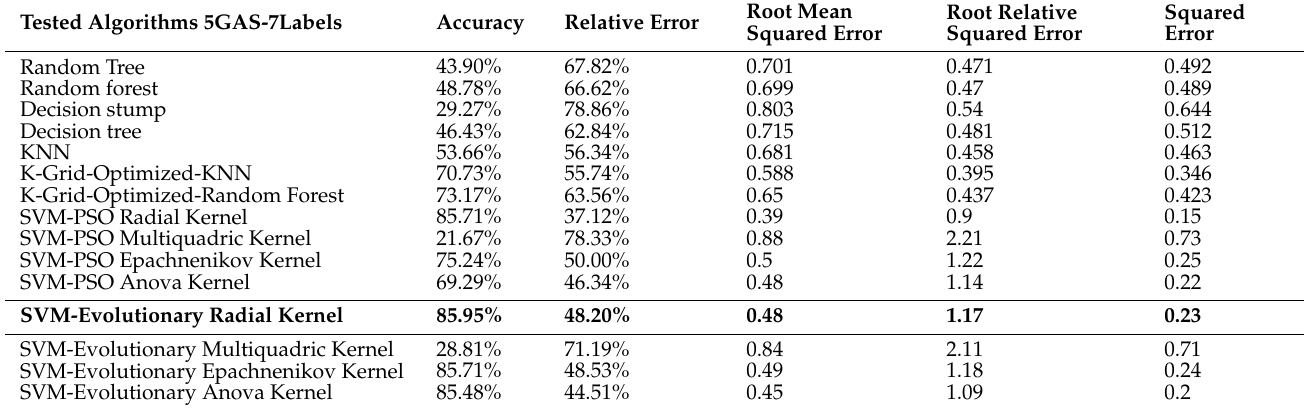
Table 2. 5 Gas dataset comparative